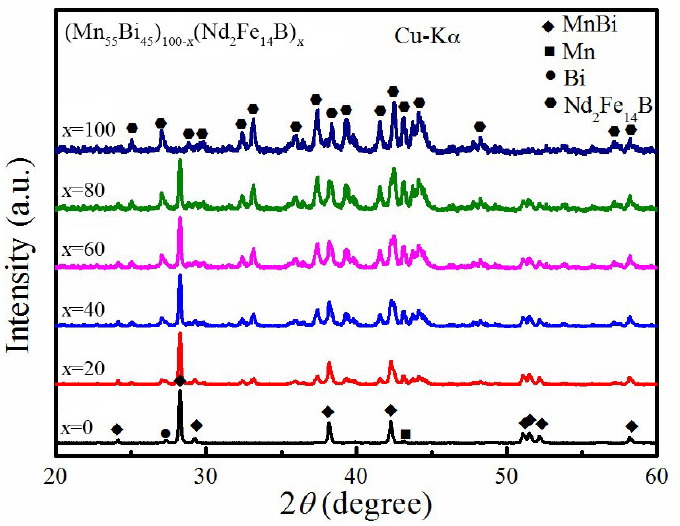
Figure 1. The XRD patterns of (Mn 55 Bi 45 ) 100 − x /(Nd 2 Fe 14 B) x ( x = 0, 20, 40, 60, 80, and 100) hybrid magnetic powders.